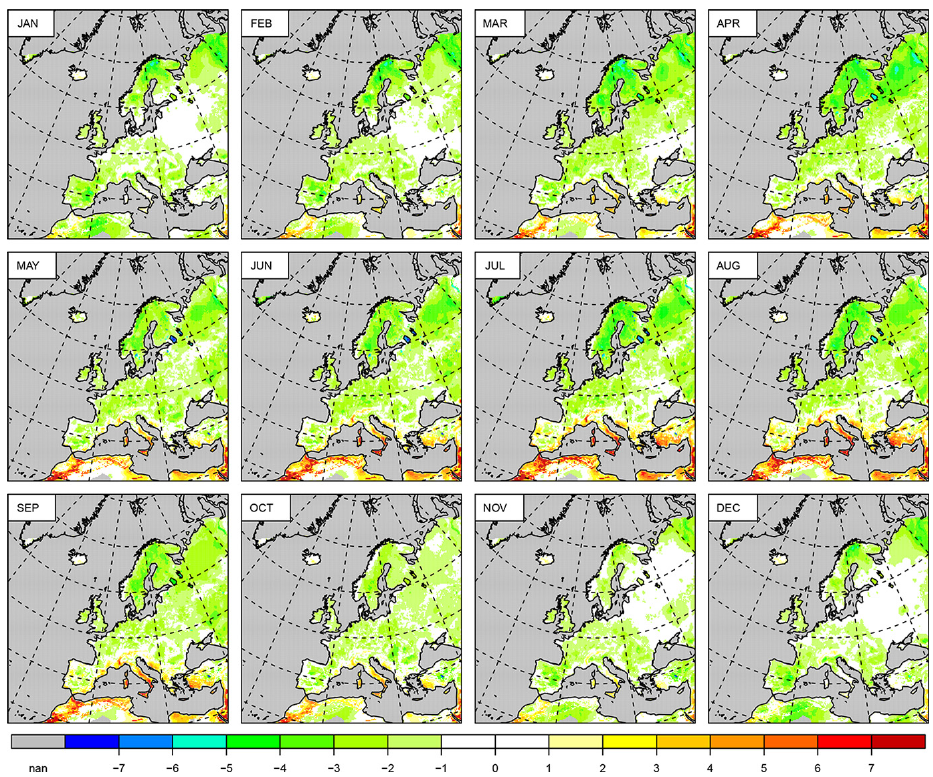
Figure 5. Di ff erences of mean diurnal temperature range [K] from 1950 to 2012: coastDat2-CCLM minus E-OBS8.0.